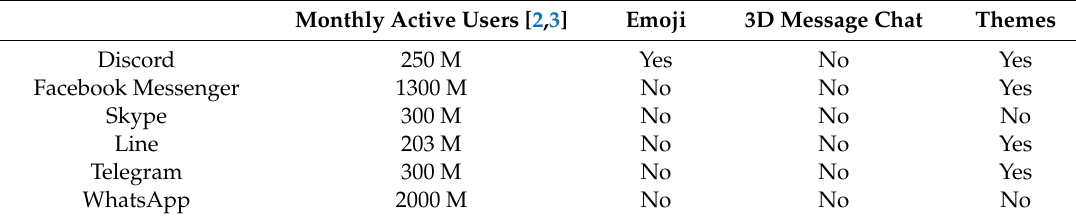
Table 1. Popular messenger services and their available features [1].